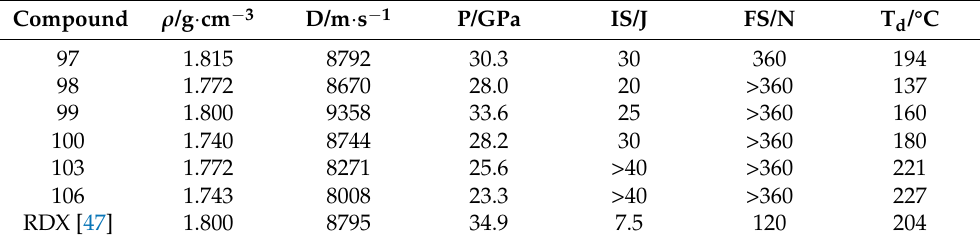
Table 2. Energetic properties and detonation parameters of ionic salts 98–100 and compounds 97 , 103 , 107